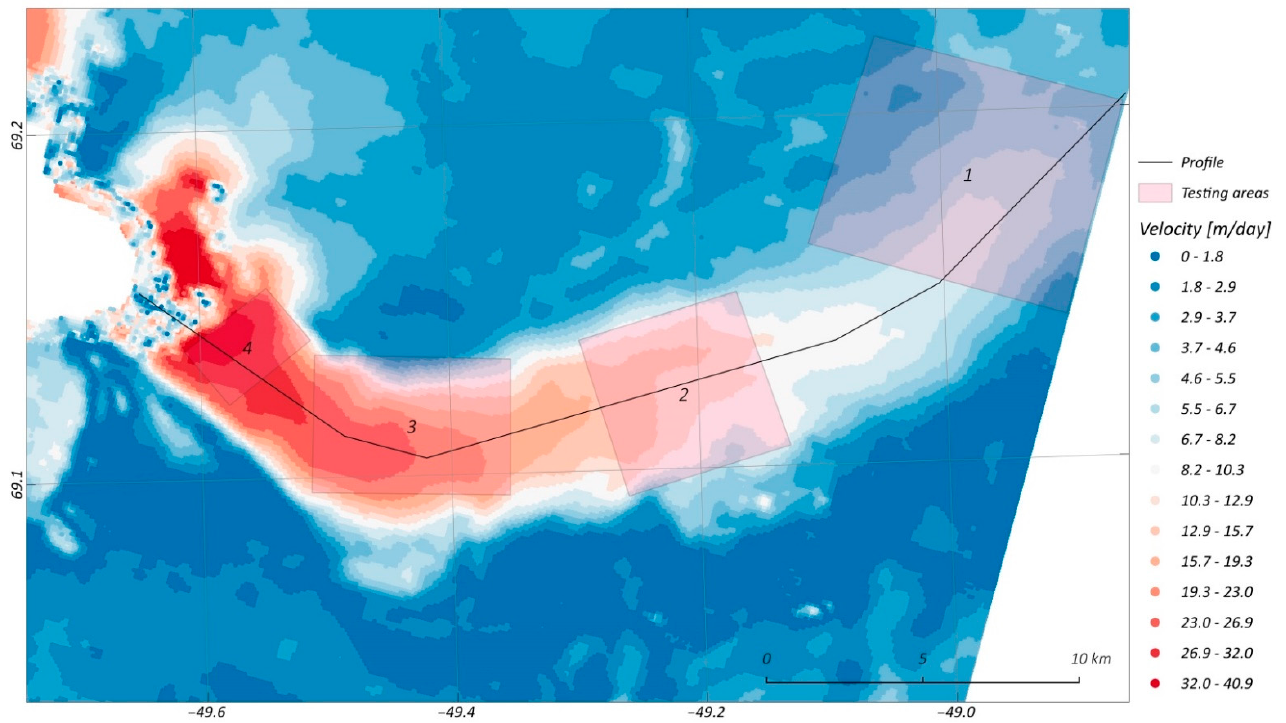
Figure 4. Areas where detailed comparative analyzes were applied and a field profile. The map shows the maximum velocity of glacier movement obtained based on the ICEYE satellite.